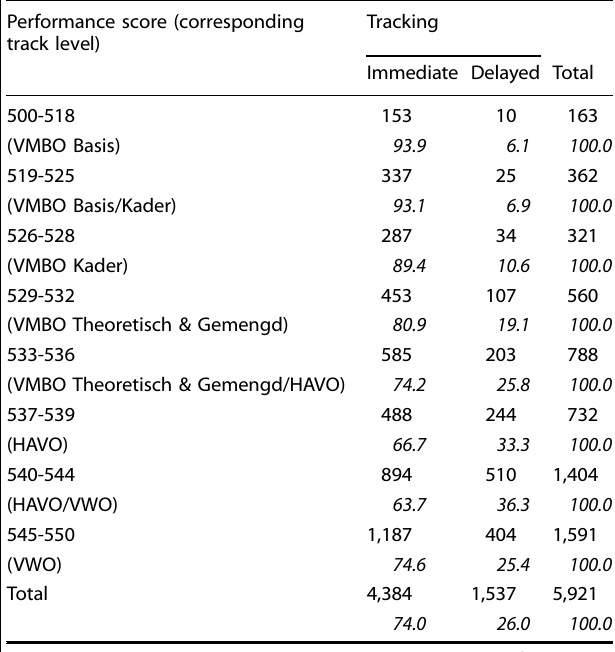
Table 4. Number and percentage with immediate and delayed tracking by educational performance